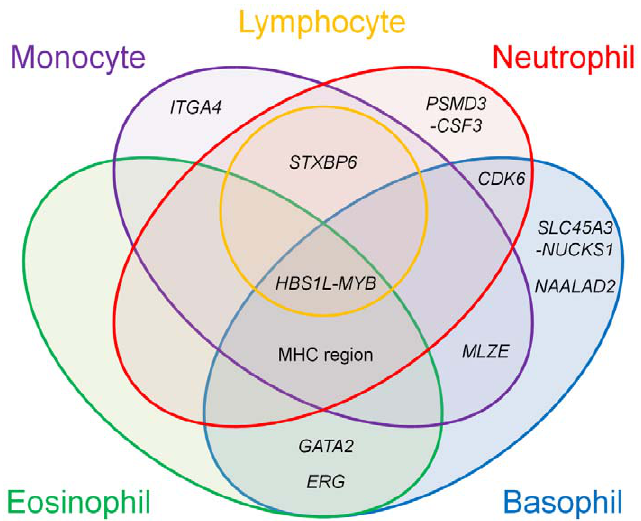
Figure 4. Venn diagram of the pleiotropic associations among the WBC subtypes. Genetic loci identified in the GWAS for the WBC subtypes are classified based on the results of the pleiotropic association study among the WBC subtypes. The colors in the Venn diagram (red, orange, purple, aqua, and green) correspond to each of the WBC subtypes (neutrophils, lymphocytes, monocytes, basophils, and eosinophils, respectively). Pleiotropic associations with P , 0.01 are included.